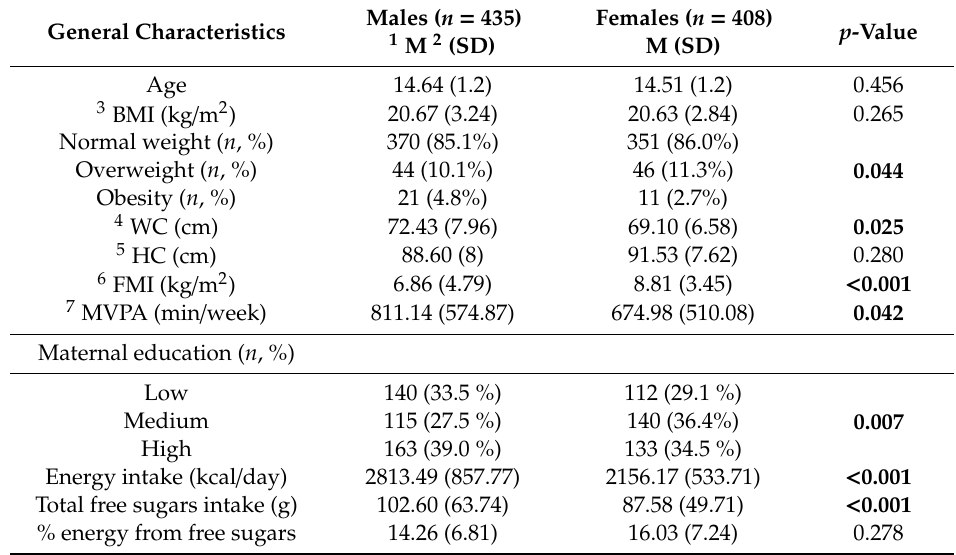
Table 1. Characteristics of the study sample and mean daily intake of energy and free sugars. Di ff erences of mean values by gender were considered using student’s t-test